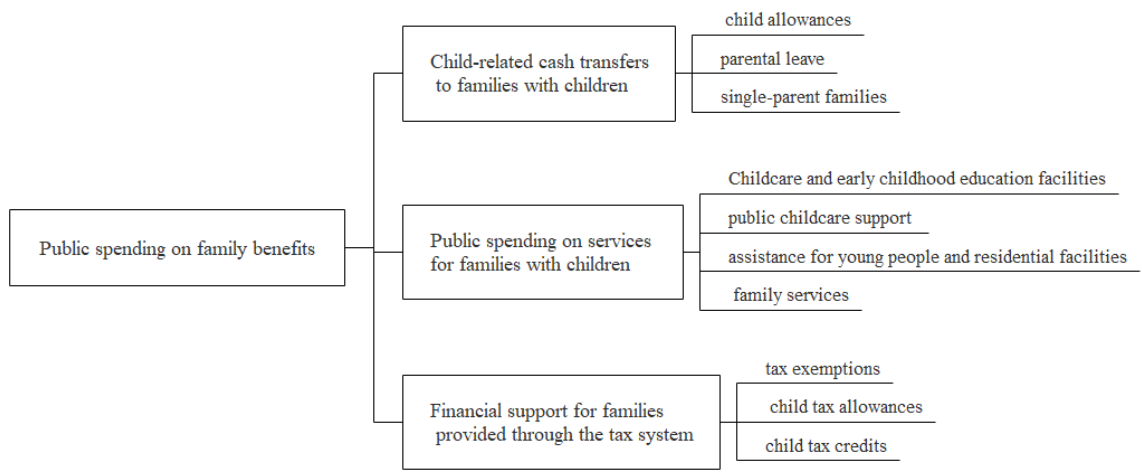
Figure 2. Family welfare policies in OECD countries.